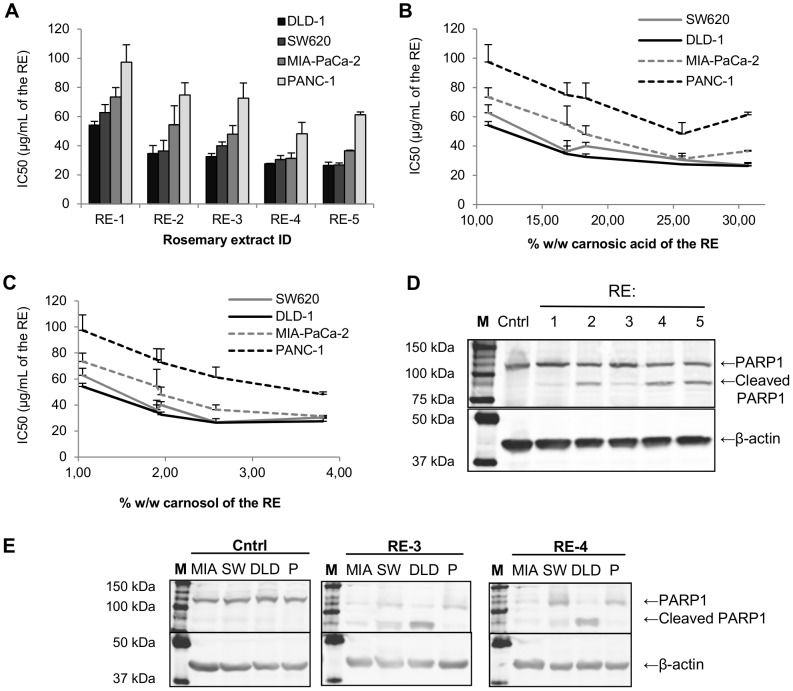
Viability inhibition and death induction of colon and pancreatic cancer cells by five different RE's.Colon (SW620 and DLD-1) and pancreatic (MIA-PaCa-2 and PANC-1) cancer cells were treated with increasing concentrations of five different RE's during 48 h and cell viability was determined by MTT assay. (A) Bars represent the IC50 values (50% cell viability inhibition) of the five different RE's in each cancer cell line. (B-C) IC50s of the five RE's in the four cancer cell lines plotted against the carnosic acid (B) or carnosol (C) content of the RE's. IC50 values are expressed as the mean ± SEM of at least three independent experiments, each performed in quadruplicate. (D-E) PARP1 cleavage induced by different RE's in colon and pancreatic cancer cells after 48 h treatment. (D) Colon cancer cells (DLD-1) were treated with 70 µg/mL of five different RE's (RE-1 to RE-5) or vehicle (Cntrl). (E) Two colon (DLD-1 and SW620) and two pancreatic (MIA-PaCa-2 and PANC-1) cancer cell lines were treated with 110 µg/mL of RE-3, 90 µg/mL of RE-4 or vehicle (Cntrl). Western blot figures show representative results of three independent experiments. DLD: DLD-1, M: marker of molecular weight, MIA: MIA-PaCa-2, P: PANC-1, RE: supercritical rosemary extract, SW: SW620.